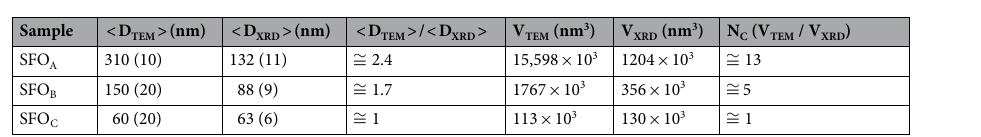
Table 1. Particle (< D TEM >) and crystallite ( < D XRD > ) average size (nm) obtained from TEM and XRPD analysis, respectively, together with the corresponding calculated volumes. The ratio between the volumes stands for the average number of crystallites within a particle ( N C ). Uncertainties in the last digit are given in parenthesis.